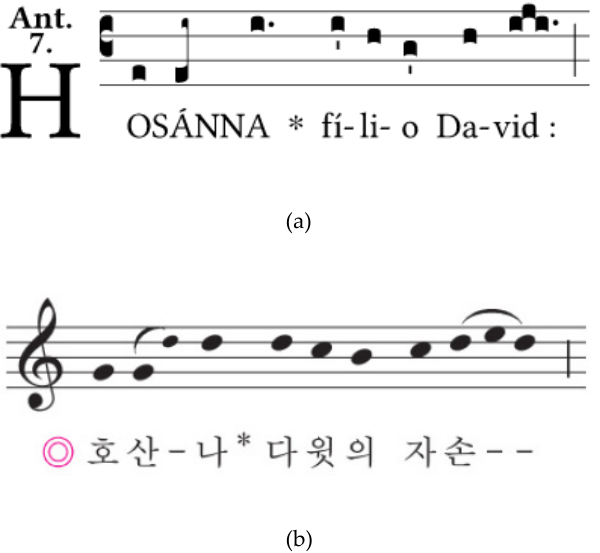
Figure 5. Comparison between the original Latin ( a ) and Korean ( b ) scores of “Hosanna filio David” (A Database of Gregorian Scores 2021; Catholic Conference of Korea 2021).